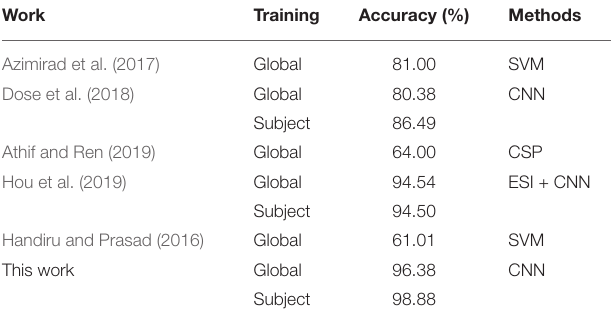
TABLE 4 | Performance comparison with other